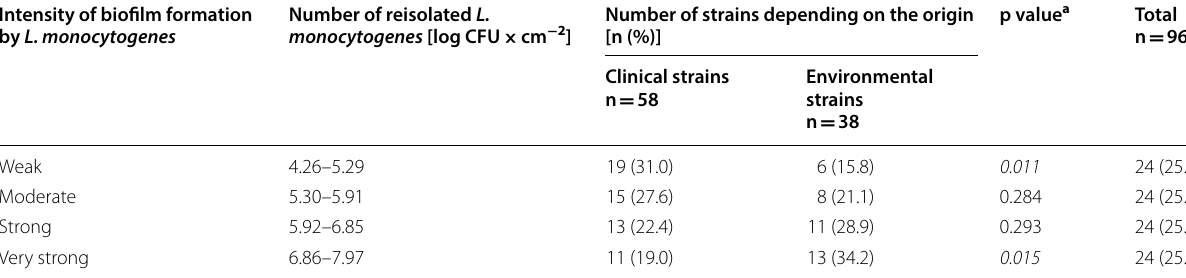
Table 3 Classification of tested L. monocytogenes rods depending on the biofilm formation intensity based on the number of bacteria isolated from the polypropylene surface in a quantitative method